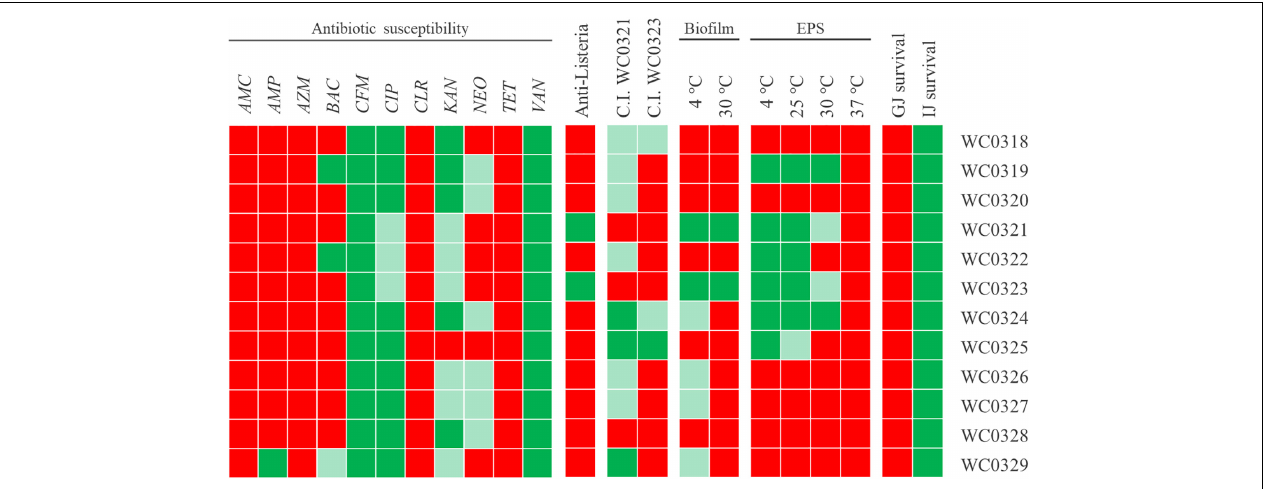
FIGURE 4 | Phenotypic traits of 12 Leuconostoc carnosum strains. Resistance (green), susceptibility (red), and intermediate behavior (light green) to amoxicillin/clavulanic acid (AMC), ampicillin (AMP), azithromycin (AZM), bacitracin (BAC), cefixime (CFM), ciprofloxacin (CIP), clarithromycin (CLR), kanamycin (KAN), neomycin (NEO), tetracycline (TET), and vancomycin (VAN); anti -Listeria activity and Cross-Immunity test (red, absence of growth inhibition; light green, inhibition zone with diameter < 10 mm; green, diameter ≥ 10 mm); biofilm production (red, OD 570 /OD 600 < 1; light green, ≥ 1; green, ≥ 5); EPS production (red, normal colonies; light green, slightly mucoid colonies; green, mucoid aspect); survival to gastric and intestinal juices (red, absence of viable cells; green, presence of residual growth).